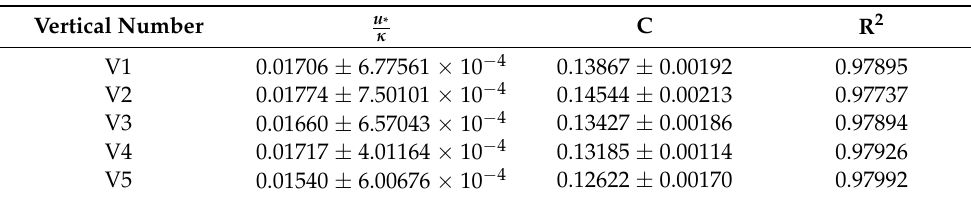
Table 2. The longitudinal velocity fitting parameters with the Prandtl logarithmic distribution formula at section S3 of Straight II.